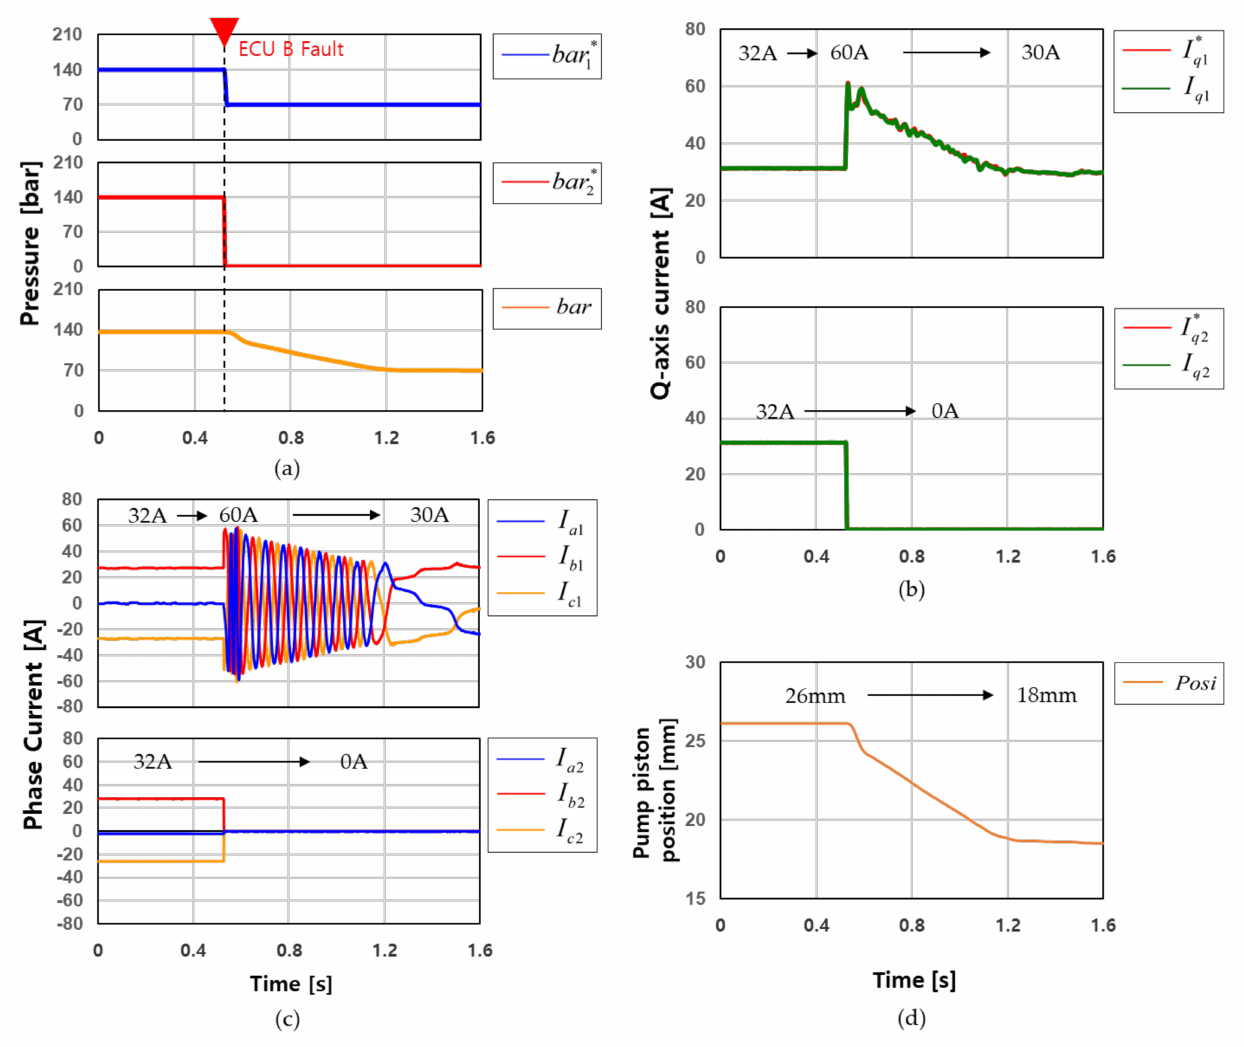
Figure 13. Measurement results when the malfunctioning of ECU B occurs: ( a ) target pressure ( bar ∗ , bar ∗ ) and measured pressure (bar); ( b ) q − axis current command value ( I ∗ 2 1 q − axis current value ( I q 1 , I q 2 ); ( c ) measured three-phase current ( I a 1 , I b 1 , I c 1 ) , ( I a 2 , I b 2 , I c 2 ) ; ( d ) cal- culated pump piston